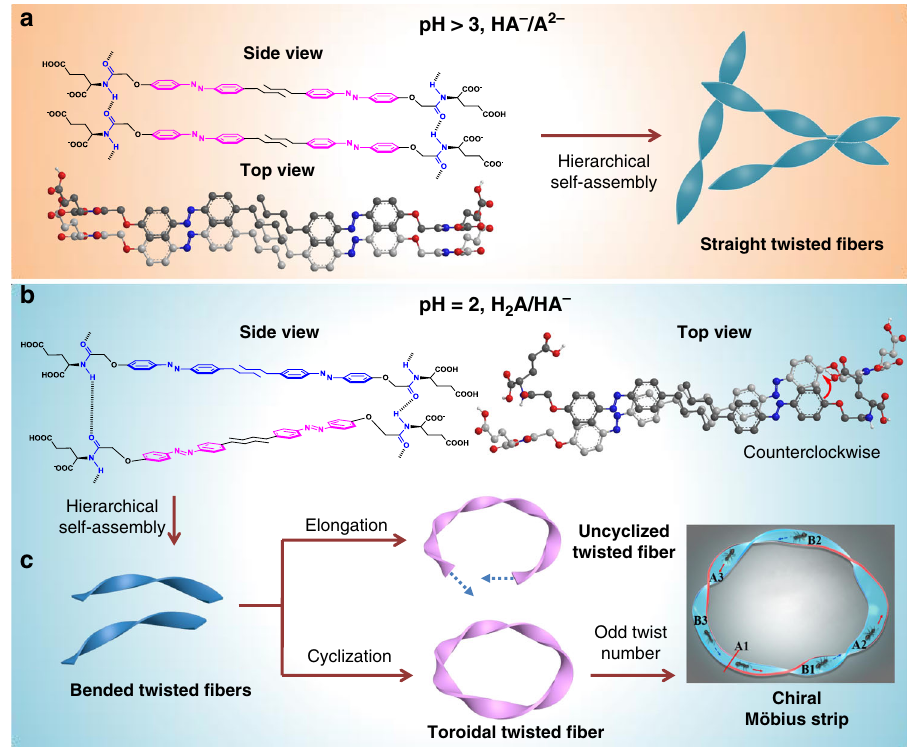
Fig. 7 Schematic illustration of proposed molecular stacking mode, self-assembly, and cyclization process. a When pH >3, the major components HA − and A 2 − of L-3 amphiphile molecules form a bilayer structure mainly through azobenzene π - π stacking and hydrogen bonding between amide groups, the tiny molecular length difference of HA − and A 2 − lead to the formation of straight twisted fi bers. b When pH = 2, the major components H 2 A and HA − of L-3 amphiphile molecules form a counterclockwise bilayer stacking due to the obvious molecular length difference of H 2 A and HA − . c Illustration of two possible elongation pathways for bent twisted fi bers. When the two fi ber terminals are not in a plane, further elongation leads to the formation of uncyclized twisted fi bers, otherwise, further elongation leads to the cyclization of twisted fi bers and formation of chiral nanotoroids and Möbius strips. The cartoon fi gure at the bottom right corner represents a quintuple twisted Möbius strip, if an ant starts from side A1 and proceeds sequentially through B1 backside, A2, B2 backside, A3 and B3 backside (red solid arrows), it will fi nally arrive at the backside of the starting side A1. Upon continuing for a second cycle through A1 backside, B1, A2 backside, B2, A3 backside and B3, the ant will fi nally arrive back at the starting